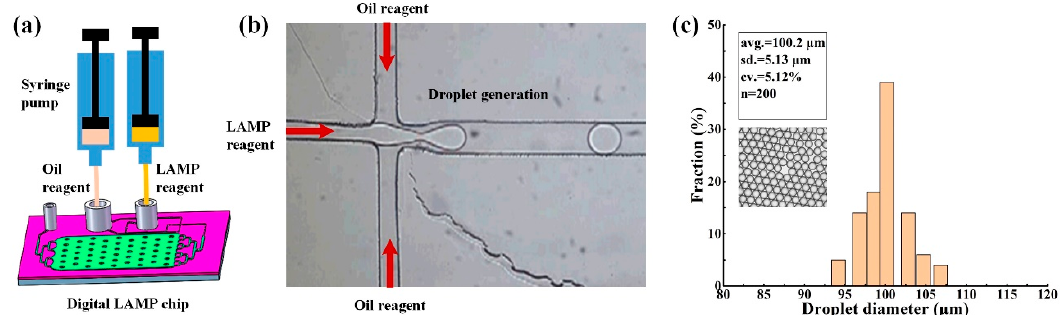
Figure 7. Schematic illustration and characterization of droplet generation. ( a ) Device schematic. ( b ) Instant image during droplet generation. ( c ) The droplet size distribution.